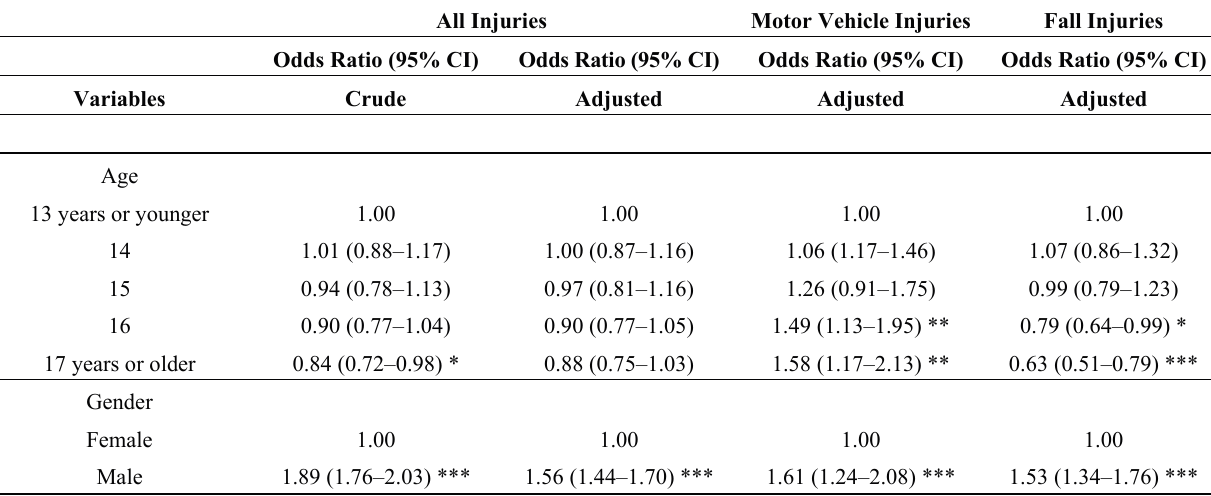
Table 4. Logistic regression analysis for associations with injury (all injury types) and restricted analysis for motor vehicle and fall